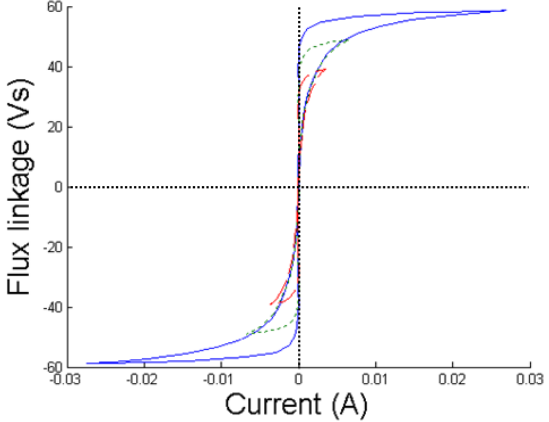
Figure 6. λ -i m curves for 120%, 100%, and 80% of the rated voltage.